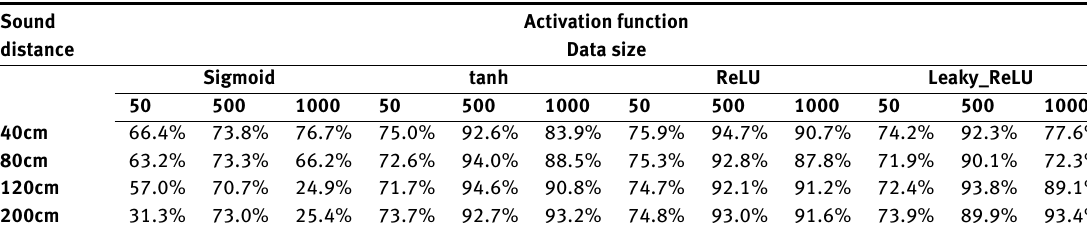
Table 7: The accuracy of different data sizes in the anechoic chamber.